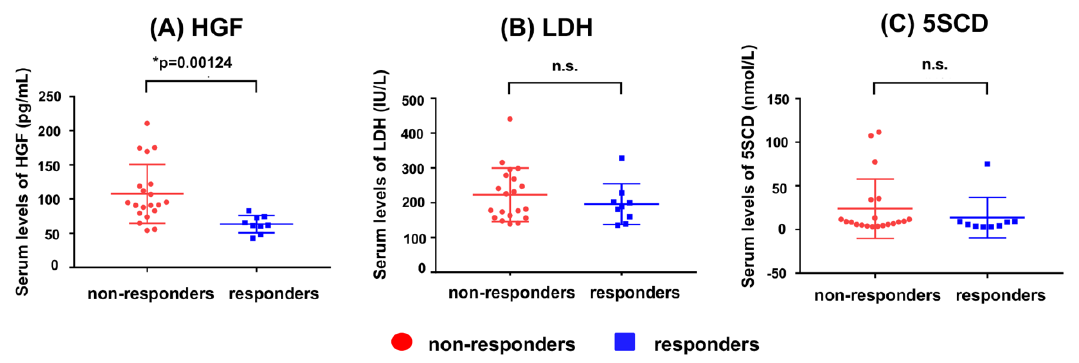
Figure 3. The serum concentration of hepatocyte growth factor (HGF) ( A ), LDH ( B ) and 5SCD ( C ) in non-responders and in responders to anti-PD-1 therapy. This Figure was modified with the consent of authors (Kubo et al.